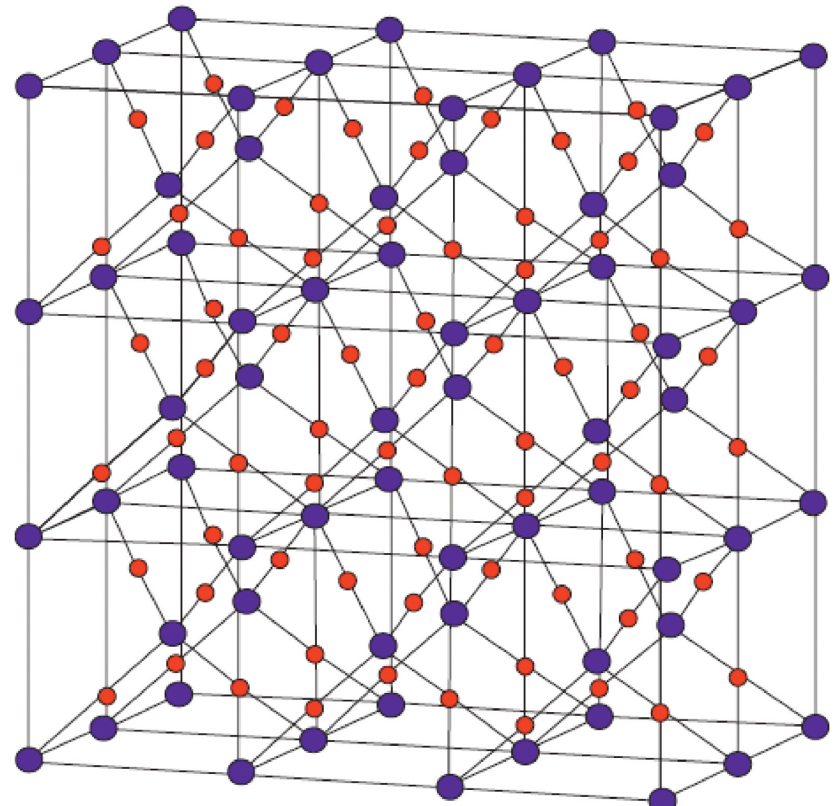
Figure 3: The graph of Cu